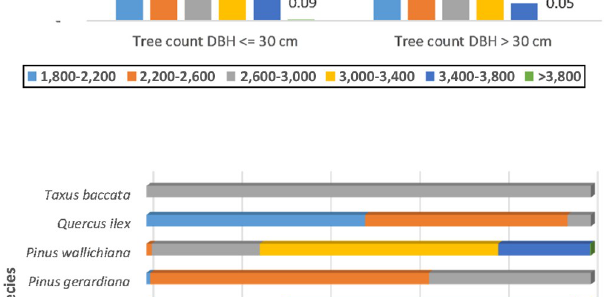
Figure 4. Elevation interval- wise percentage distribution of tree